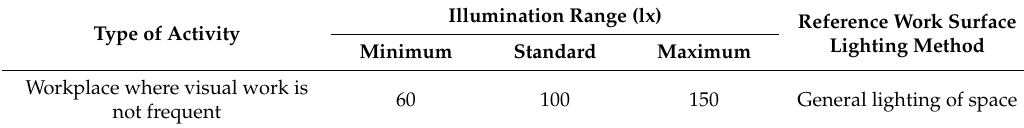
Table 5. KS A 3011 Recommended levels of illumination.